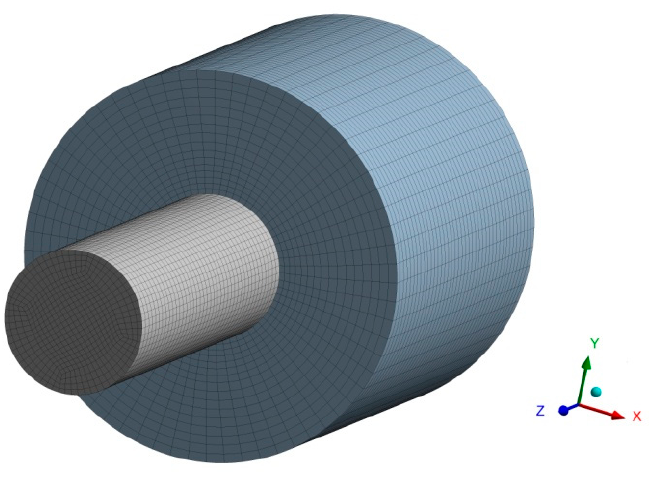
Figure 3. A discrete